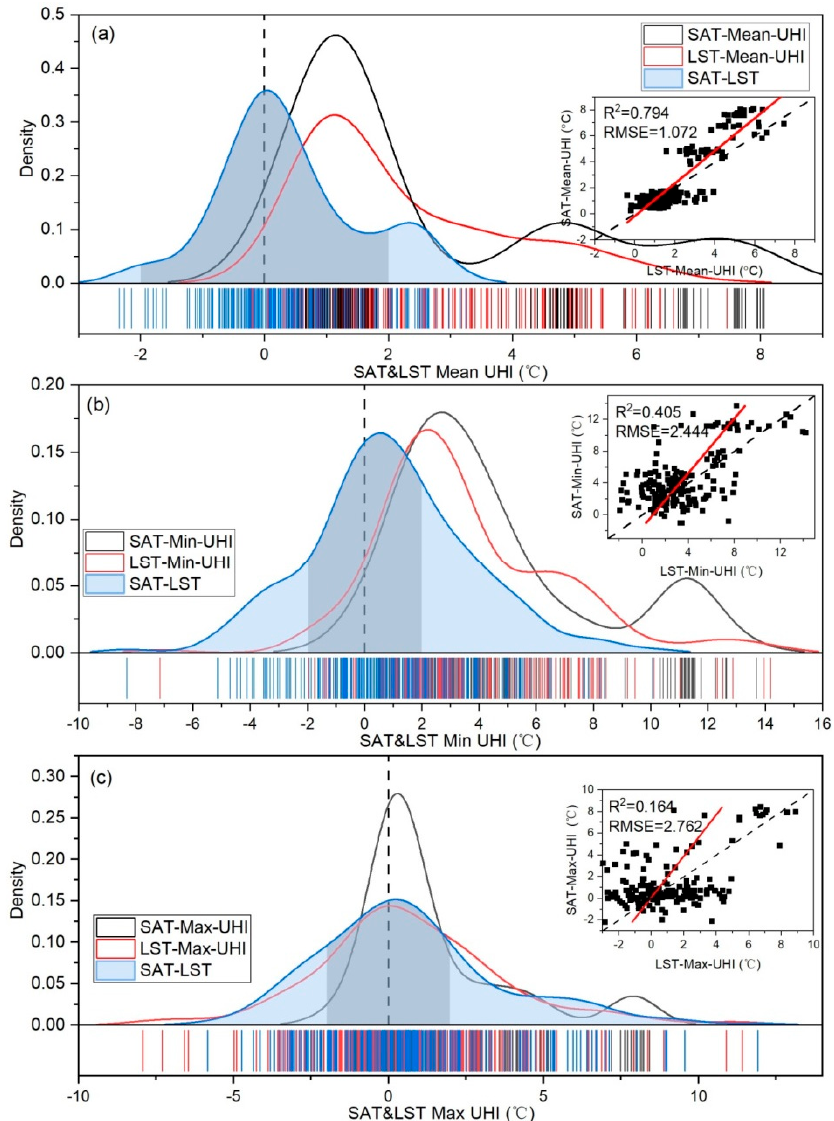
Figure 4. Statistical distributions and linear fittings between LST-UHI (urban heat island) and SAT-UHI for mean ( a ), minimum ( b ) and maximum ( c ) temperatures. Blue area means the differences between SAT-UHI and LST-UHI, gray shadows means the proportions of differences within the [–2, 2] range. Dotted lines are references of 0.0 for X axis and 1:1 line for subplots. The vertical dotted line indicated the zero reference.